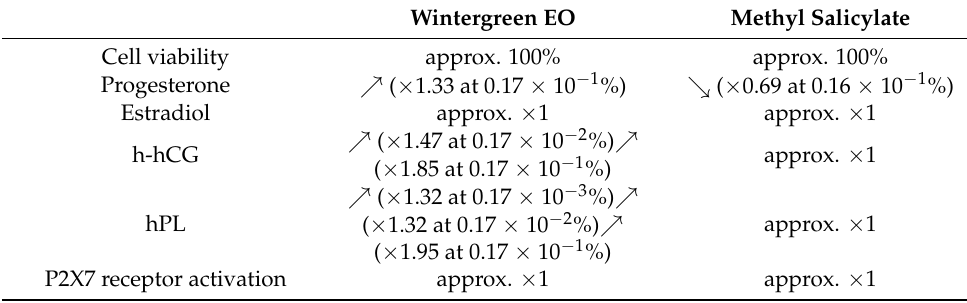
Table 5. Summary of the results of wintergreen EO compared to methyl salicylate. Wintergreen EO Methyl Salicylate Cell viability approx. 100% approx. 100% Progesterone